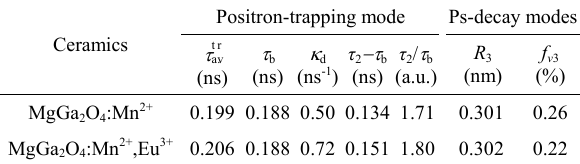
PAL trapping modes for studied spinel- structured ceramics within unconstrained x3-term decomposition ignoring contributions from o-Ps decay Positron-trapping mode Ps-decay modes